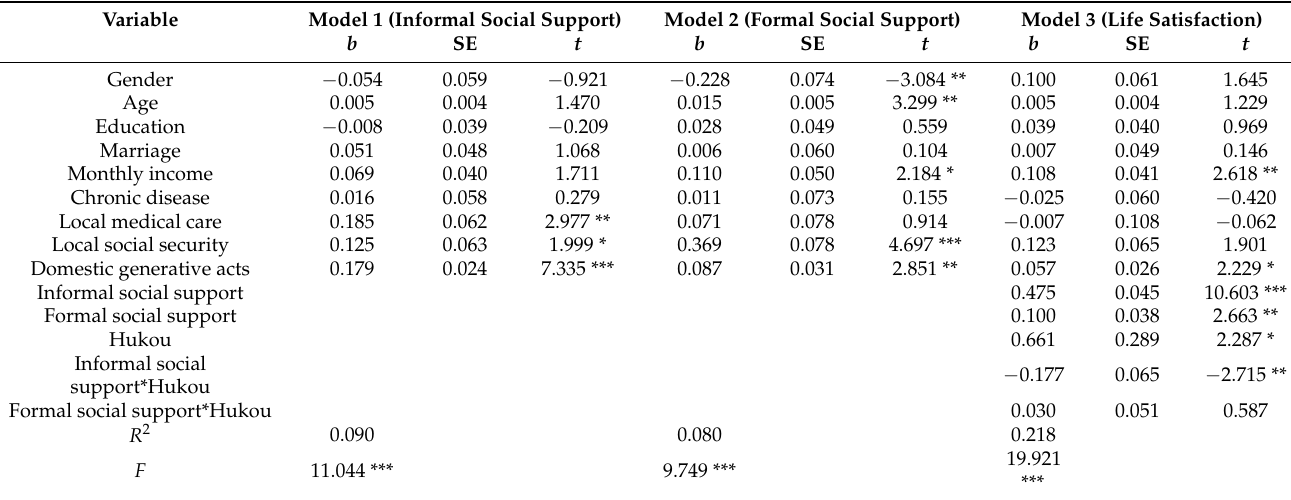
Figure 1. Structural model of domestic generative acts, informal/formal social support, and life satisfaction. χ 2 (195) = 505.533, p < 0.001, CFI = 0.973, TLI = 0.964, RMSEA = 0.040, SRMR = 0.045. * p < 0.05; *** p < 0.001. Table 5. Results of moderated mediation analysis for life